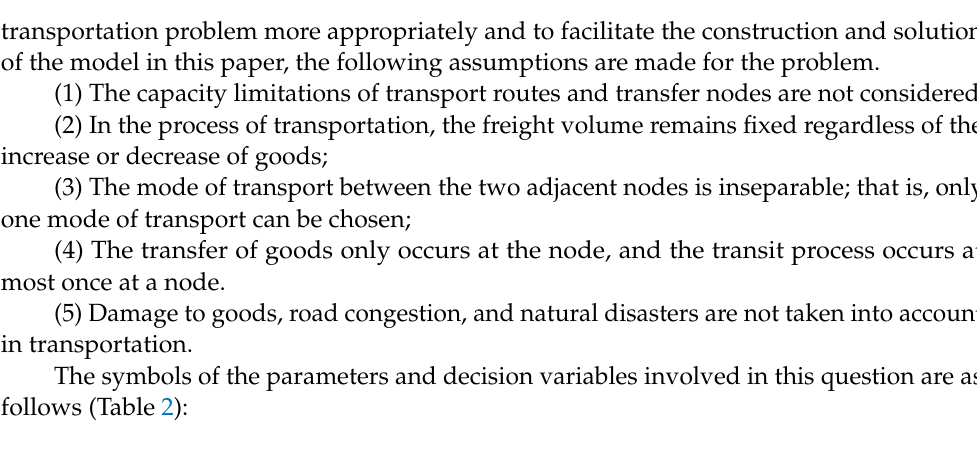
Table 2. Symbol description of parameters and decision